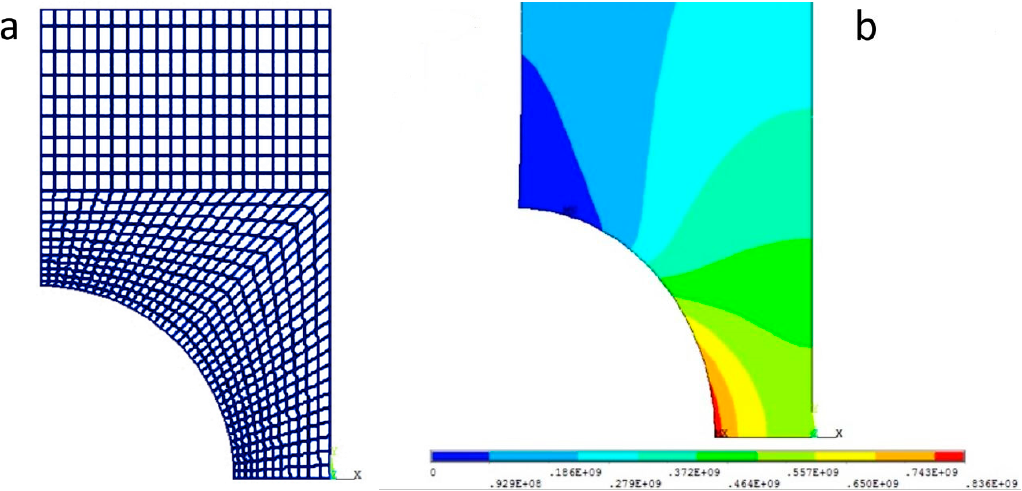
Figure 2. Mesh of the specimen with a double circular notch ( a ) and principal stress (S1) distribution ( b ).